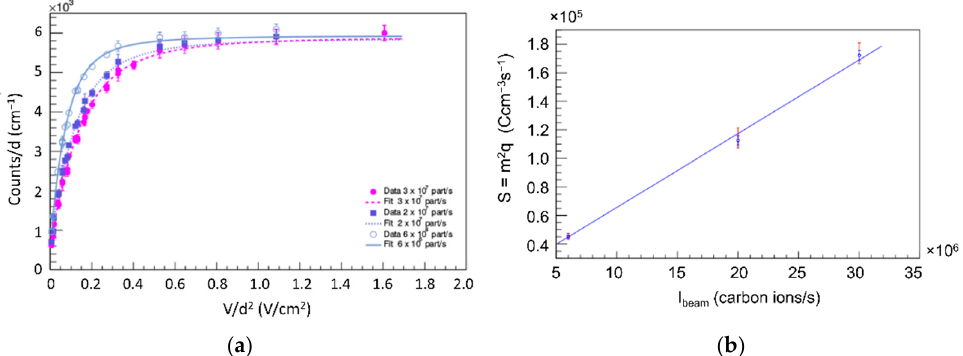
Figure 5. ( a ) Total counts normalized to the detector gap for three beam intensities (0.6 × 10 7 , 2 × 10 7 and 3 × 10 7 carbon ions/s) and fits to measurements from all the chambers. ( b ) Rate of ionization (S) as a function of the measured beam current.